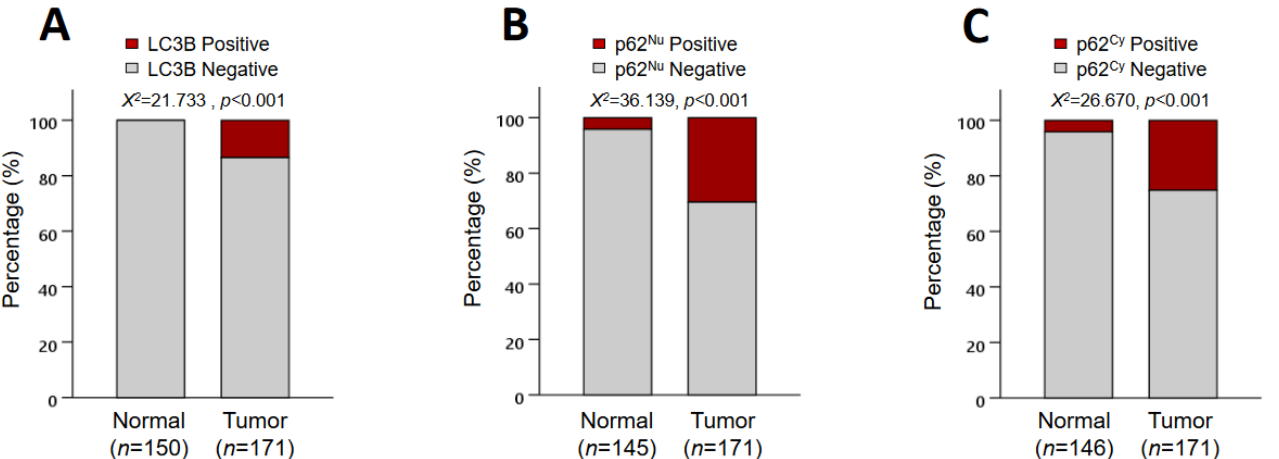
Figure 3. LC3B and p62 expression in SIAC and non-neoplastic small intestinal epithelial cells. LC3B was expressed in malignant tumor cells but not in non-neoplastic epithelial cells ( p < 0.001) ( A ). P62 Nu + ( B ) and p62 Cy + ( C ) expressions were more frequently observed in carcinoma than in non-neoplastic epithelium (both p <